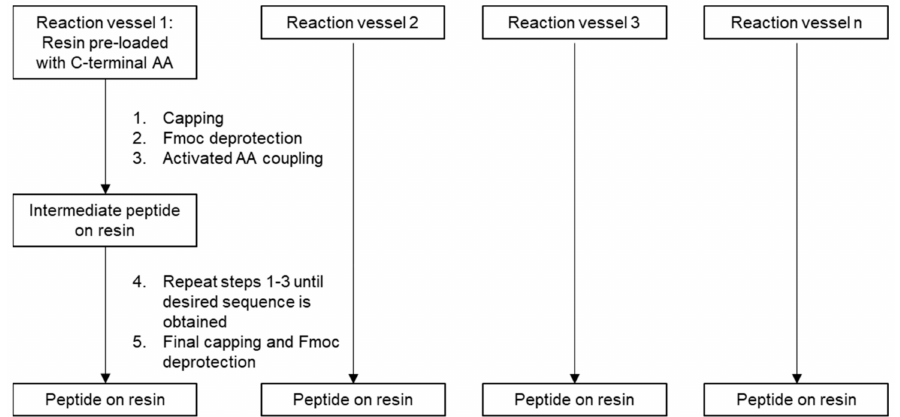
Figure 2. Schematic representation of the automated peptide synthesis